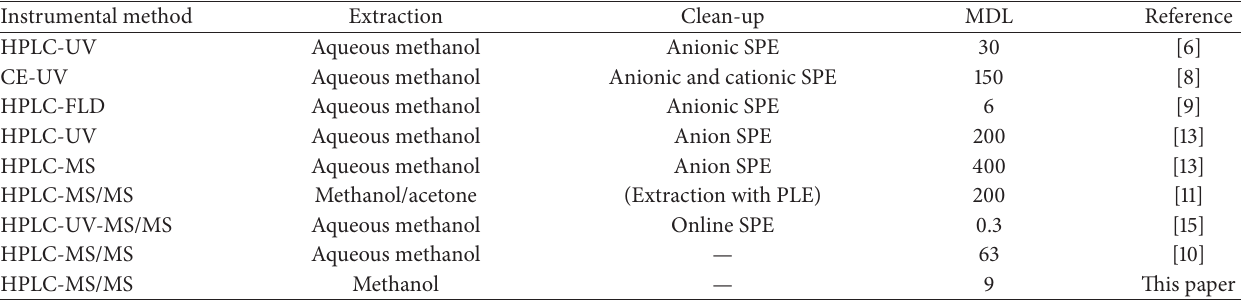
Table 2: A comparison between existing methods and the proposed method in this